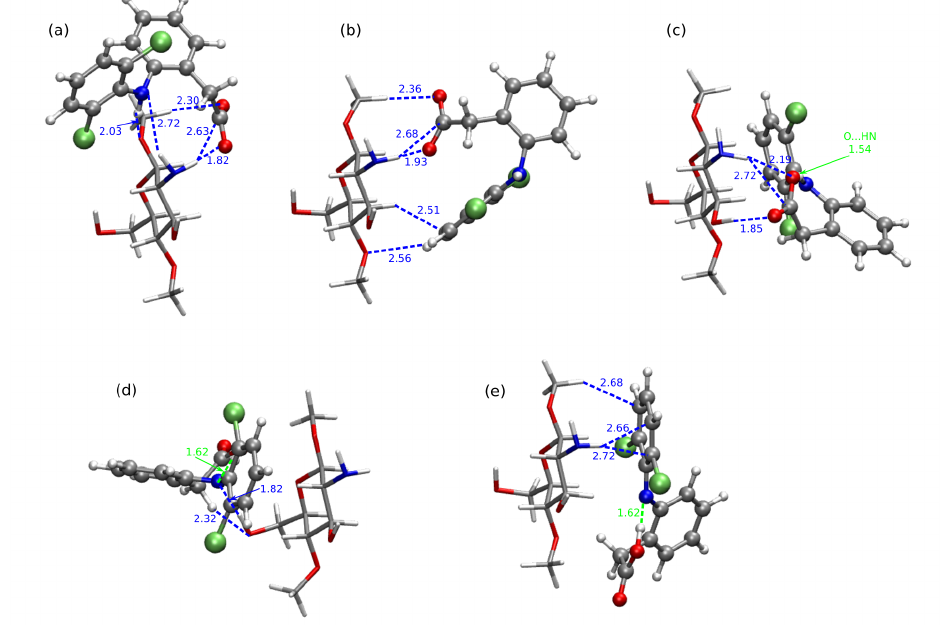
Figure 4. B97-D3/6-311++G(d,p) optimized most structures of chitozan unit interacting with DF − with corresponding interaction energies, ( a ) CS1:DF − 3 , ( b ) CS1:DF − 7a , ( c ) CS1:DF − 4 , and two least stable structures exhibiting a intramolecular proton transfer in DF − moiety, ( d ) CS1:DF − 5-PT and ( e ) CS1:DF − 1-PT (explicit given the distances of the hydrogen–hydrogen-bond-acceptor distances in Å: green for intramolecular interaction and blue for intermolecular interaction). DF − presented in Corey–Pauling–Koltun (CPK) representation and CS1—in licorice with following atom colors: chlorine—lime green, oxygen—red, nitrogen—cobalt blue, carbon—silver, hydrogen—white. PT denotes the proton